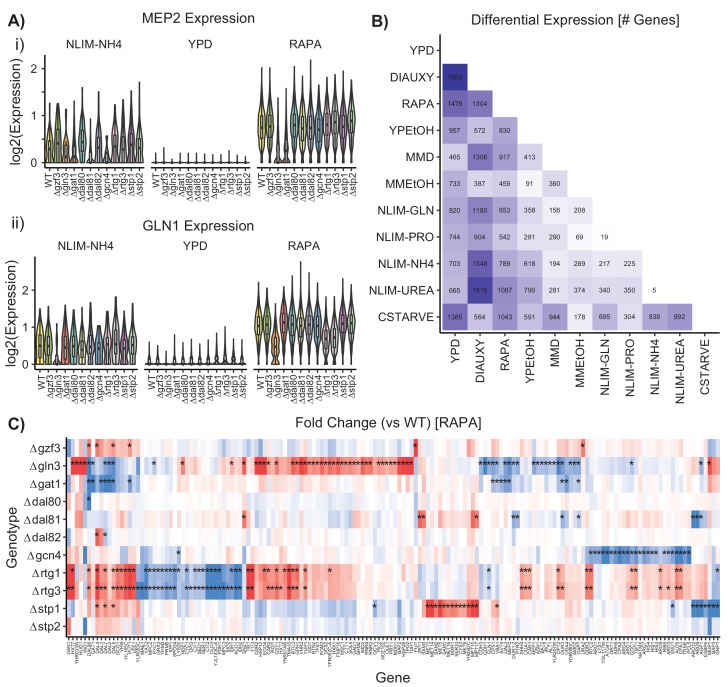
Differential Gene Expression Varies by Condition.(A) Distribution by strain genotype of the log2 batch-normalized expression of the ammonium permease gene MEP2 and the glutamine synthetase gene GLN1 in YPD, RAPA, and ammonium limitation. (B) Number of differentially expressed genes identified after bulking between wild-type cells in each growth condition (C) Log2(fold change) of genes differentially expressed in TF knockout strains compared to wildtype, when grown in YPD and then treated with rapamycin. Asterisks denote statistically significant differences in gene expression [1.5-fold change; p.adj <0.05].